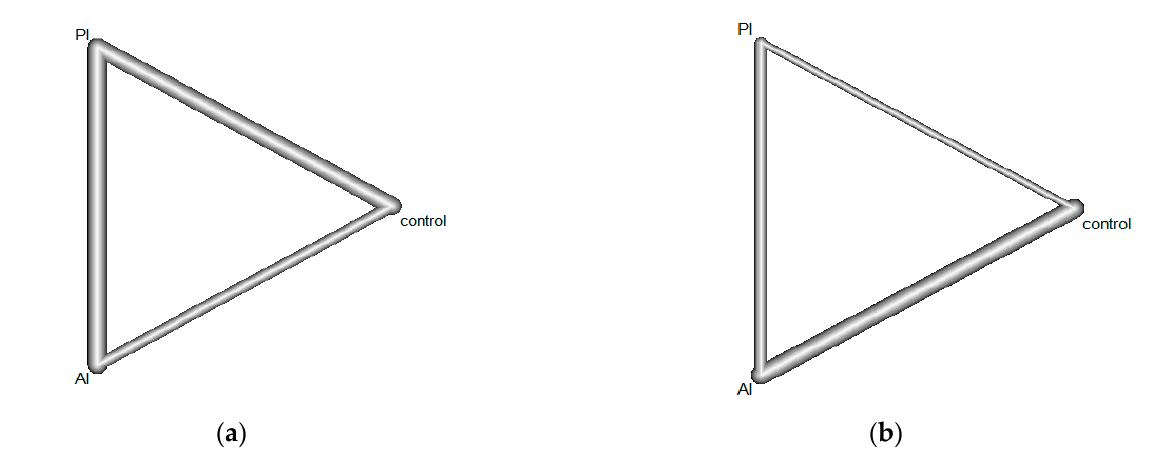
Figure 2. Net graphs of included studies. AI, active intervention; PI, passive intervention. ( a ) Net graph of pain; line thickness indicates number of studies with AI vs. PI ( n = 5), AI vs. control ( n = 3), and PI vs. control ( n = 4). ( b ) Net graph of navicular drop; line thickness indicates number of studies with AI vs. PI ( n = 3), AI vs. control ( n = 5), and PI vs. control ( n = 1).